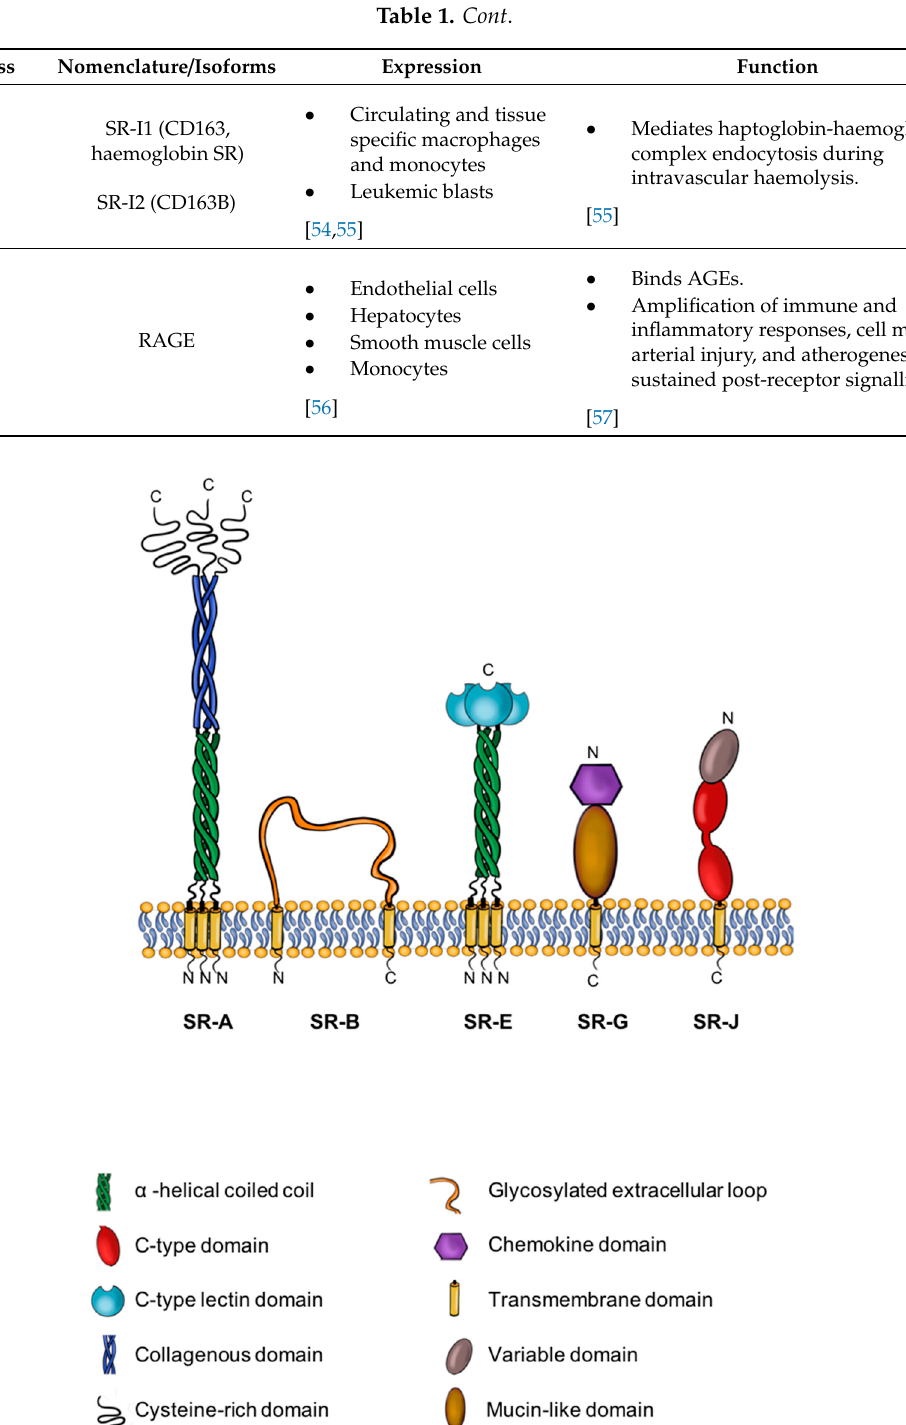
Figure 2. Five different SR classes (A, B, E, G, J) are most closely linked to the initiation and progression of atherosclerosis. These molecules are potential biomarkers and therapeutic targets. Their structures are represented in the sketches above. Abbreviations: N-terminus, N; C-terminus, C.